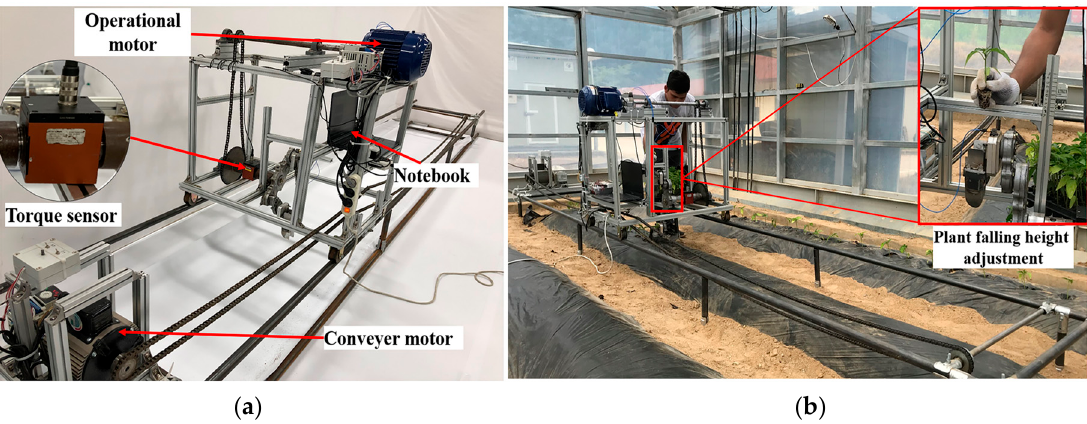
Figure 5. Test bench for pepper transplantation using the dibbling mechanism ( a ), and field experiment photo ( b ).